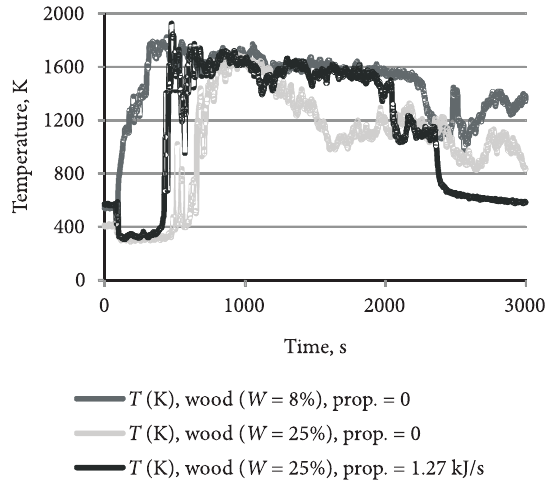
Fig. 2. Temperature changes (K) for wood pellets of different moisture content combustion with and without propane- butane supply